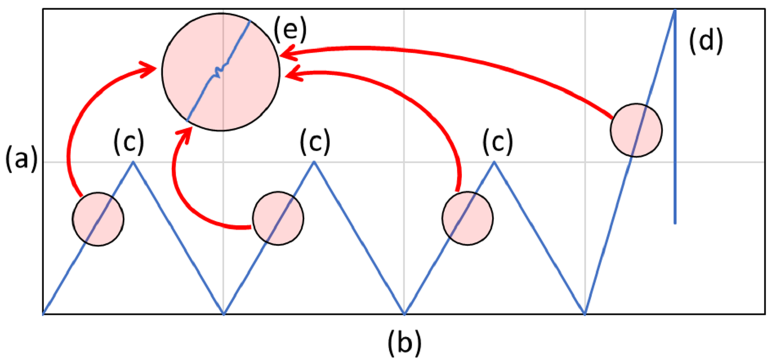
Figure 2. Stepwise loading applied in the present study. (a) Load (N). (b) Time (s). (c) Load limitation (10 kN). (d) Ultimate load (N). (e) Early failure during stepwise loading.